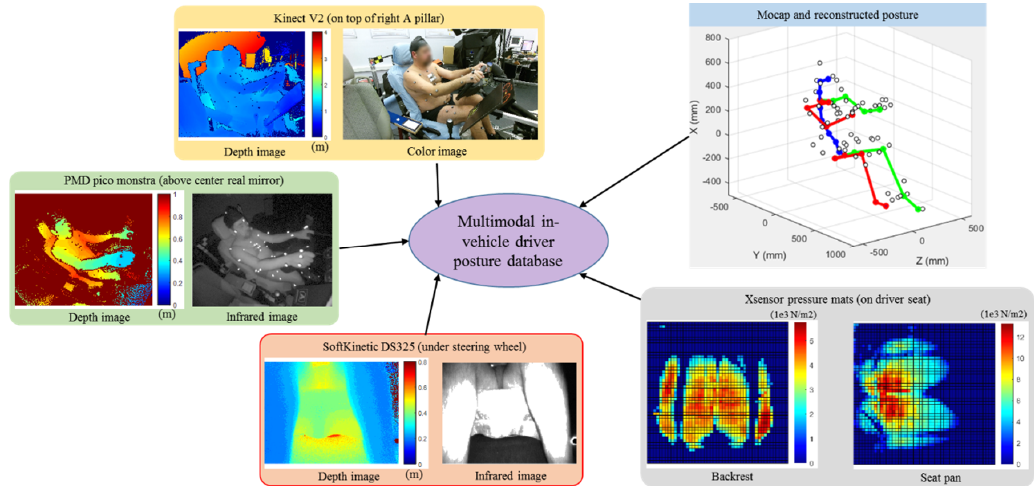
Figure 1. Driver posture dataset.